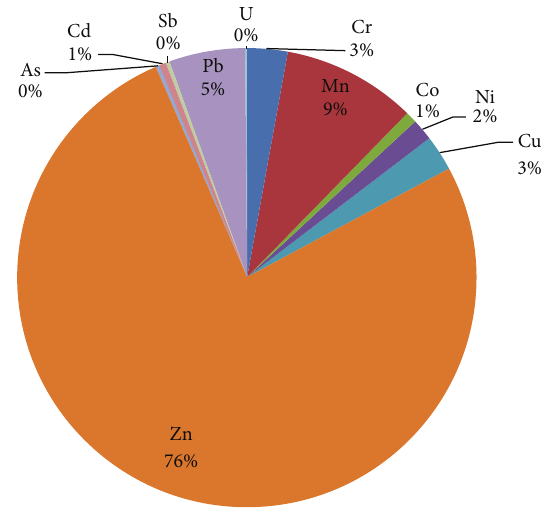
Figure7:Distributionoftracemetalsindustsamplescollectedfrom School G.